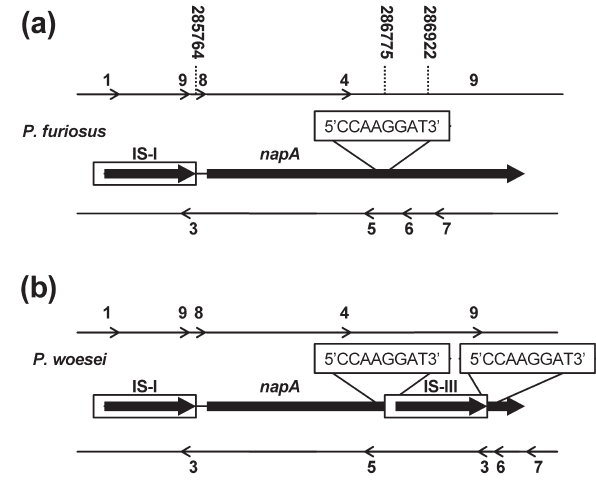
Figure 4. Maps of insertion sequence (IS) elements in the napA loci of (a) P. furiosus and (b) P. woesei . Parallel lines represent double- strandedDNAs. Boxes with thickarrows representIS elements.Thick arrows represent genes. Arrowheads on the thin lines represent for- ward (pointing right) and reverse primers (pointing left) (see binding coordinates in Materials and methods). Coordinates in the P. furiosus genome are shown by the vertical dotted lines. Direct repeat se- quences are boxed. The napA gene in P. woesei contains two IS ele- ments, including the type I IS in the same context as in the genome of P. furiosus